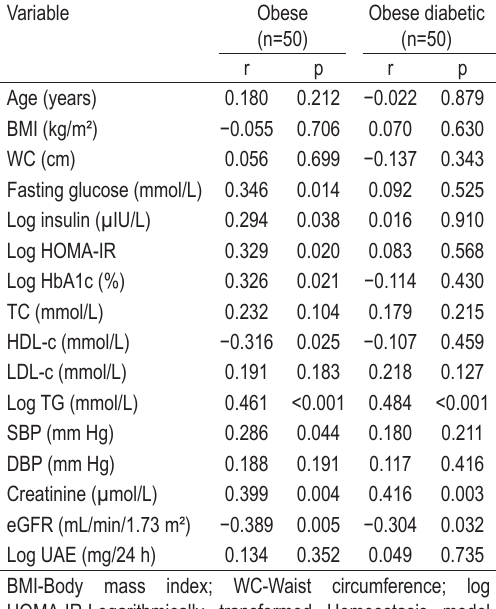
TABLE 2. Pearson’s correlation coefficients (r) of RBP4 and studied parameters among obese non‑diabetic and obese diabetic postmenopausal women